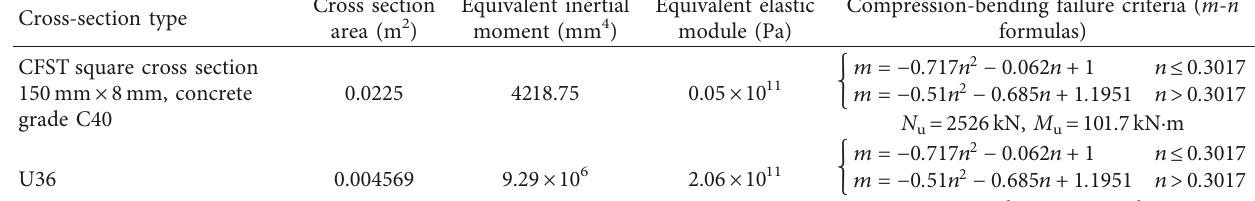
Table 3: Geometry and mechanical parameters of the supporting arches.